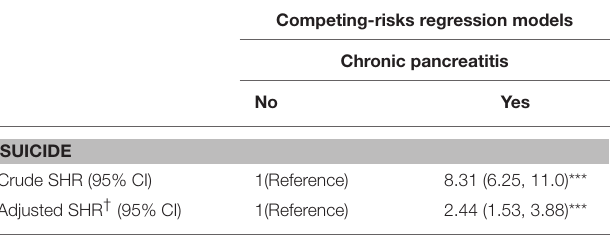
TABLE 5 | Subhazard ratio (SHR) of suicide attempt for chronic pancreatitis cohort and non-chronic pancreatitis cohort estimated using competing-risks regression models.